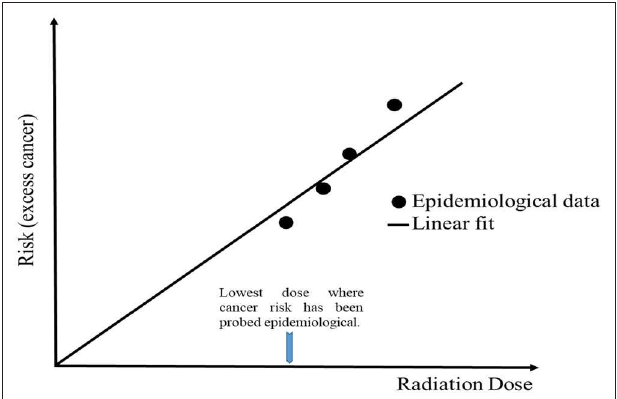
FIGURE 1 | LNT dose response model for radiation-induced stochastic health effects estimation. Its straight line extrapolated to zero assuming radiation has the potential to cause lesions at any dose value.